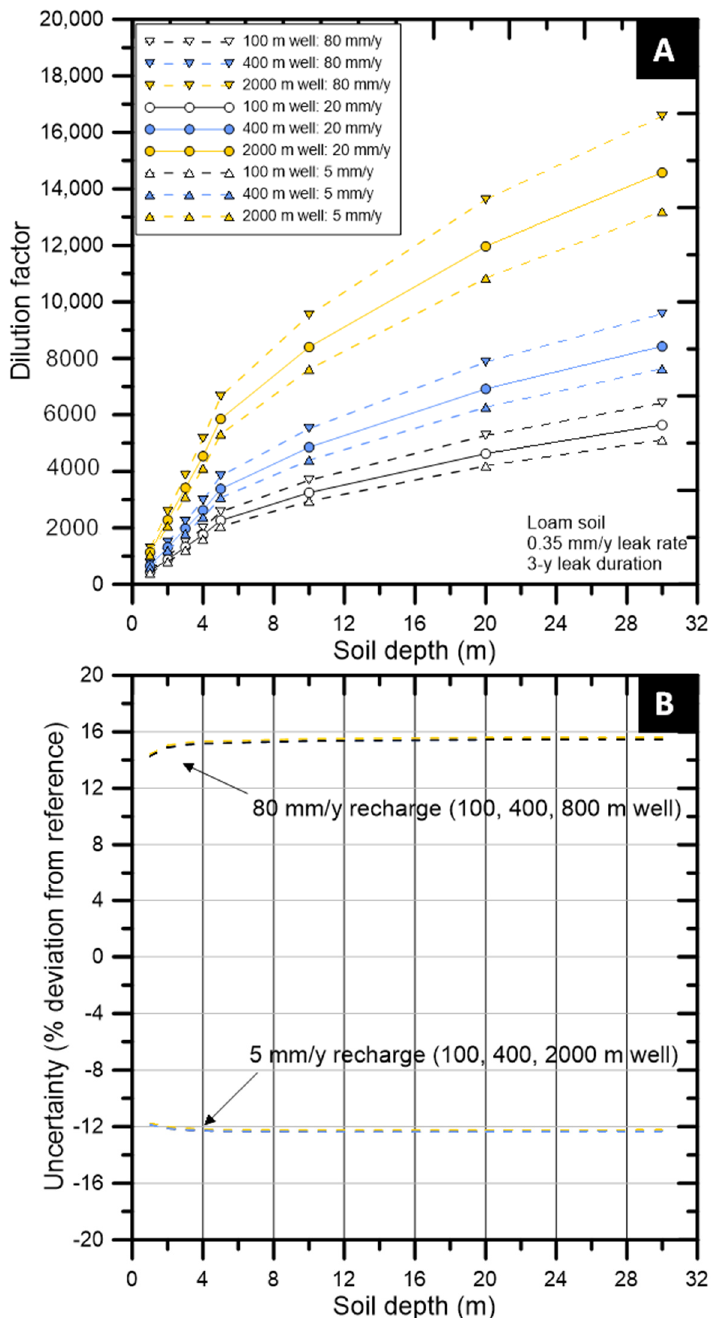
Figure 8. Combined dilution factor ( DF ) for loam soil (0.35 mm/y leak rate) with three recharge rates and groundwater pathway for reference groundwater conditions (A). Uncertainty (in % deviation from reference) as function of soil depth, groundwater travel distance, and recharge rate (B).